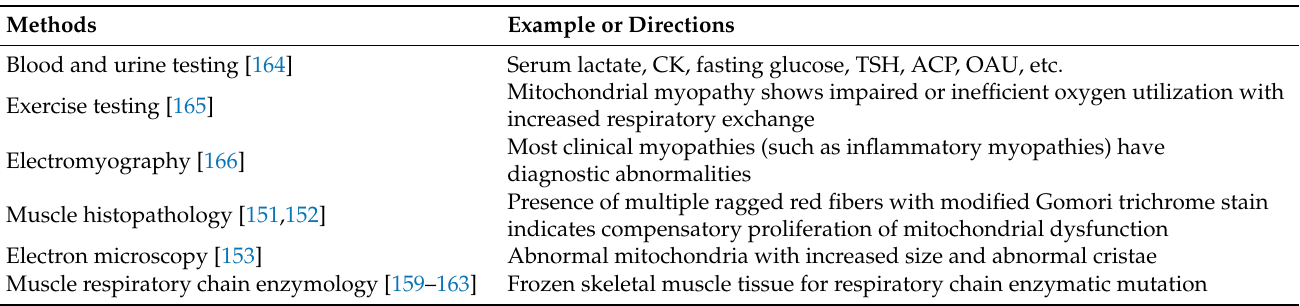
Table 1. Diagnostic studies of mitochondrial